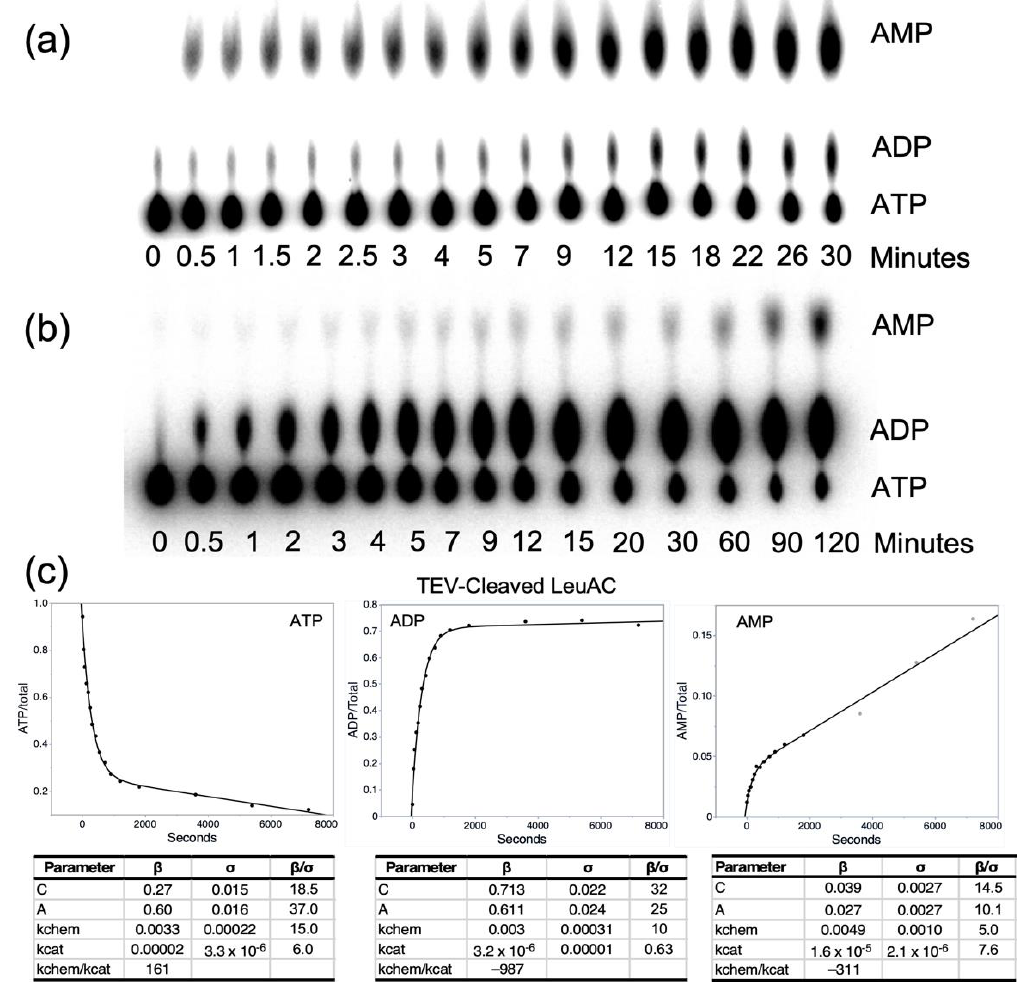
Figure 2. Time courses for the appearance of the three adenine nucleotides in active-site titration experiments with TEV-cleaved MBP- LeuAC fusion protein measured using [α - 32 P] ATP. Polyethyleneimine (PEI) thin-layer chromatograms (TLC) for full-length P. horikoshii LeuRS ( a ) and TEV-cleaved MBP LeuAC ( b ) were performed using [α - 32 P] ATP. Assays were performed as described in Section 4.5. Note the difference in timescales between the full length and urzyme proteins, as well as the different proportions of the appearance of [ 32 P] ADP and [ 32 P] AMP. ( c ) Plots of the timecourse in ( b ) fitted to Equation (1). Tables below each plot show the fitted parameters (β) their standard deviations ( σ ) and signal to noise.